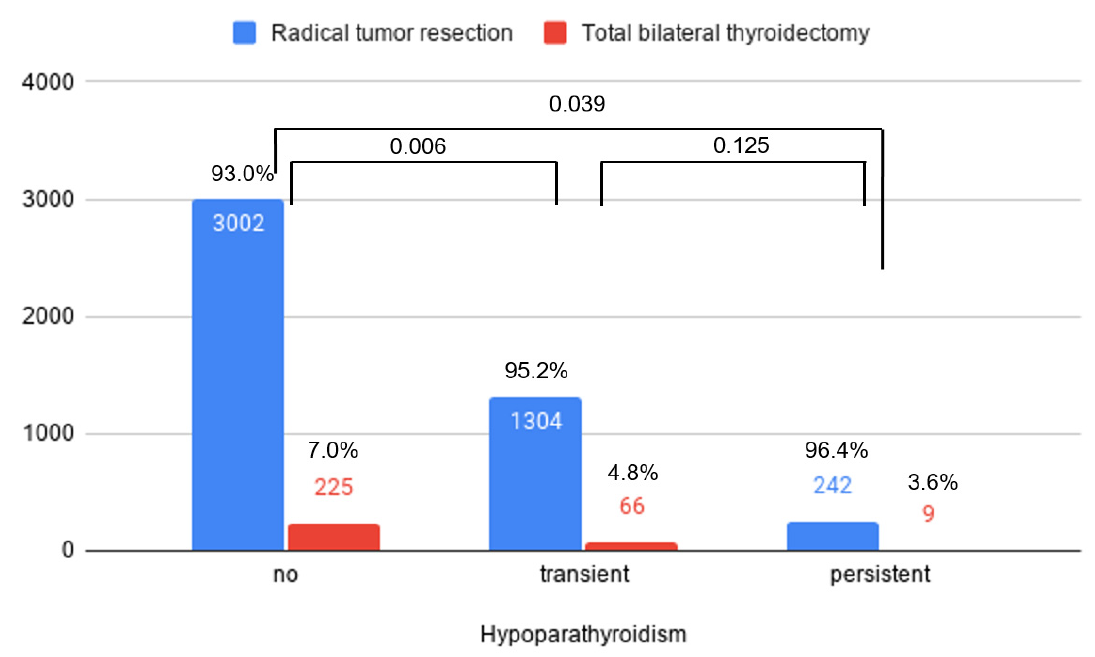
Figure 3. Post-operative hypoparathyroidism status according to operation type.